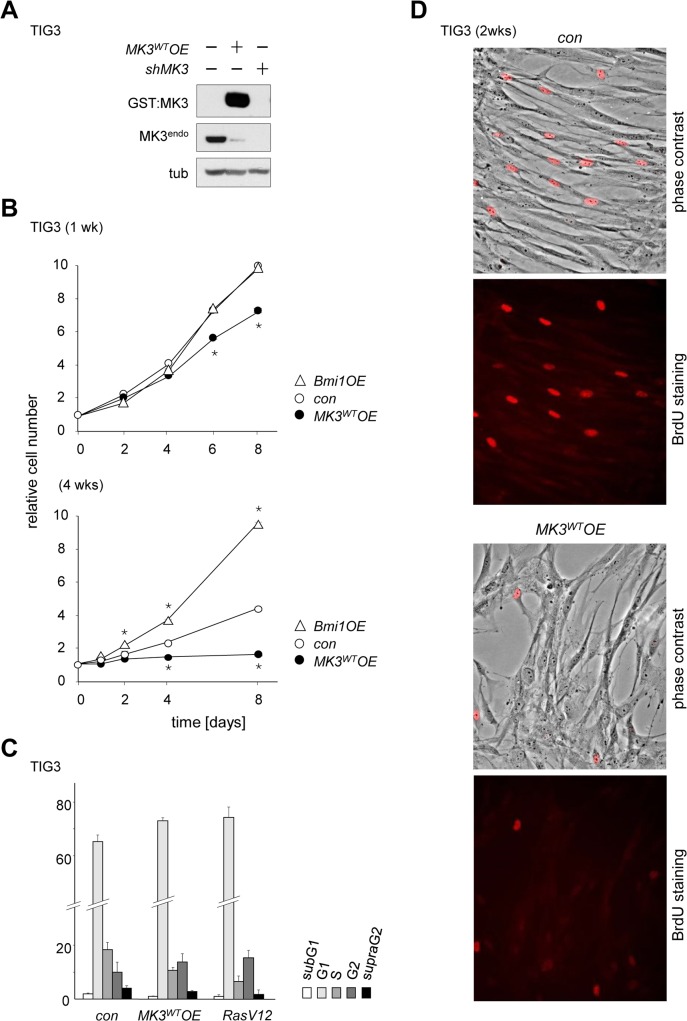

MK3
WT overexpression induces a proliferative arrest in normal human fibroblasts.(A) Retroviral expression systems were applied to enhance (MK3
WT
OE) or remove (shMK3) MK3 expression. Western blot shows MK3 proteins: endogenous (MK3endo) and overexpressed (GST:MK3). (B) Proliferation curves of TIG3 cells transduced with: a retroviral MK3 expression vector (MK3
WT
OE; filled circles), an empty vector (con; open circles) or a murine Bmi1 expression vector (open triangles); proliferation was determined at 1 week (top panel) or ±4 weeks (bottom panel) after retroviral transduction of TIG3 cells. Cell counts at t = 2 through t = 8 were normalized to cell counts at t = 0 for each transduced cell culture individually (see Methods section for details); statistical significance was determined by two-tailed Student’s t-test and is presented relative to the empty vector control (* p < 0.05). (C) Quantification of DNA profiles (BrdU pulse-labeling and S-phase quantification by FACS) in TIG3/MK3
WT
OE cells at approximately 1 week post-transduction. RasV12-transduced cells were used as a positive control. (D) MK3
WT
OE reduces de novo DNA synthesis in TIG3/MK3
WT
OE cells; cell counts: control (con) 699 BrdU-positive cells/10 fields; MK3
WT
OE: 442 BrdU-positive cells/9 fields.